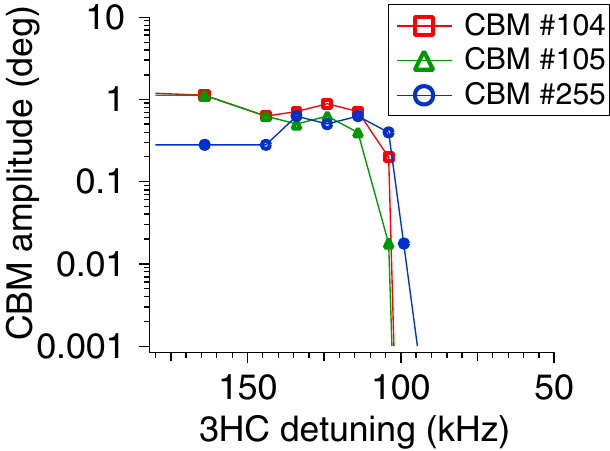
FIG. 2. (Color) CBMs amplitude versus 3HC tuning for a 80% (cid:1) 315 mA , E (cid:1) 2 : 0 GeV . filling of the ring; I beam